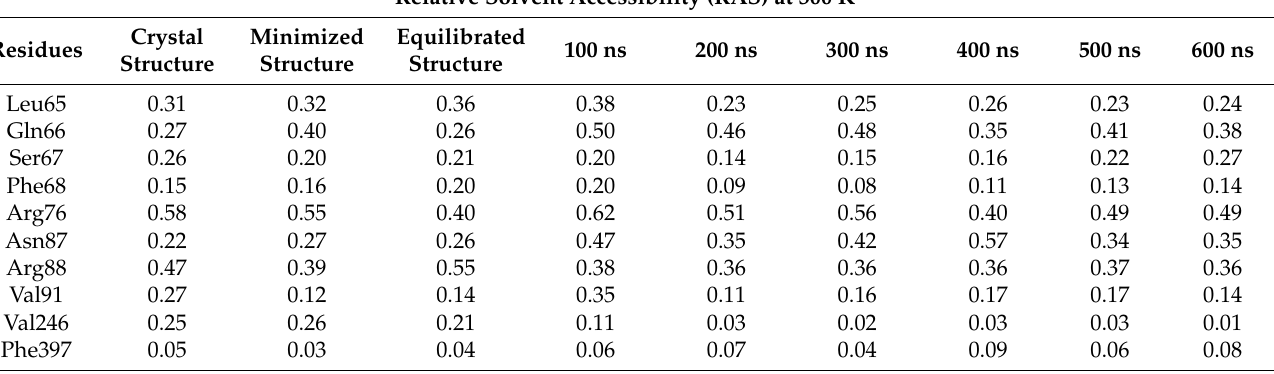
Table 1. Relative solvent accessibility of some residues of the substrate channel. Relative Solvent Accessibility (RAS) at 300